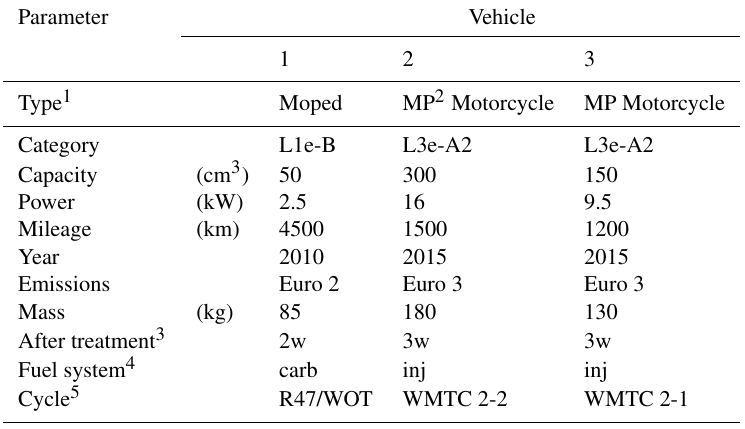
Table 1. Vehicles’ technical specifications. All vehicles were equipped with a four-stroke, spark-ignition engine and a continuously variable transmission. The reported driving cycle is the actual test cycle used in this work and not the type approval; see text for details.